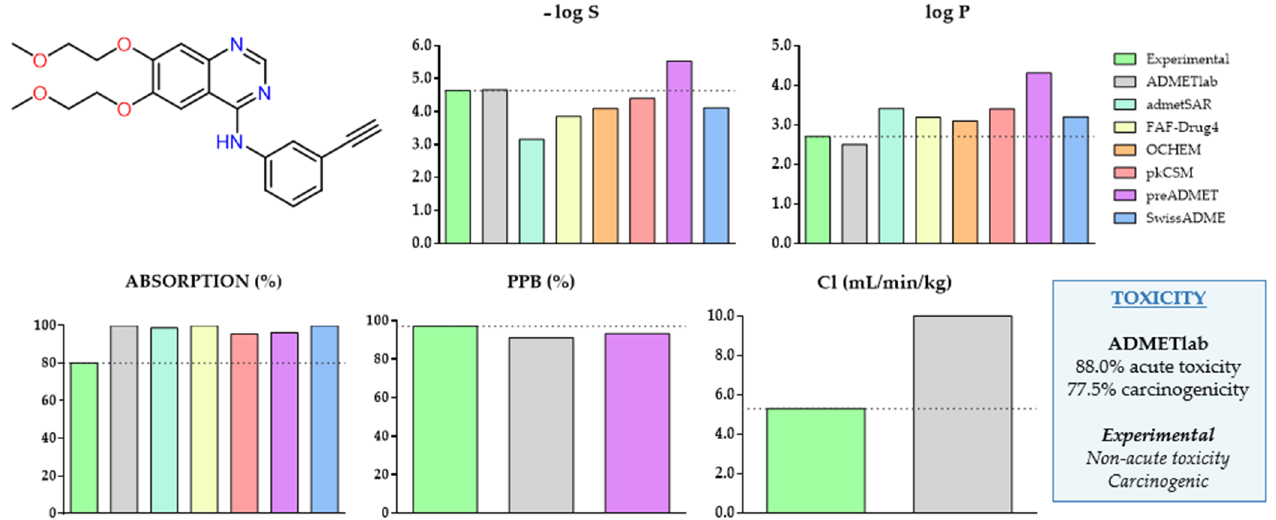
Figure 2. Comparison of the experimental data of Erlotinib ( 3 ) and the predictions obtained from ADMETlab, admetSAR, FAF-Drug4, OCHEM, pkCSM, preADMET, and SwissADME for solubility (log S), log P, absorption, plasma protein binding, clearance, acute toxicity, and carcinogenicity. Erlotinib is a quinazolinamine with a molecular formula of C 22 H 23 N 3 O 4 and a molec- ular weight of 393.44 g/mol, and it is barely soluble in water. Erlotinib is an EGFR-TKI approved by the FDA in November of 2004 as a therapy for non-small cell lung cancer (NSCLC)